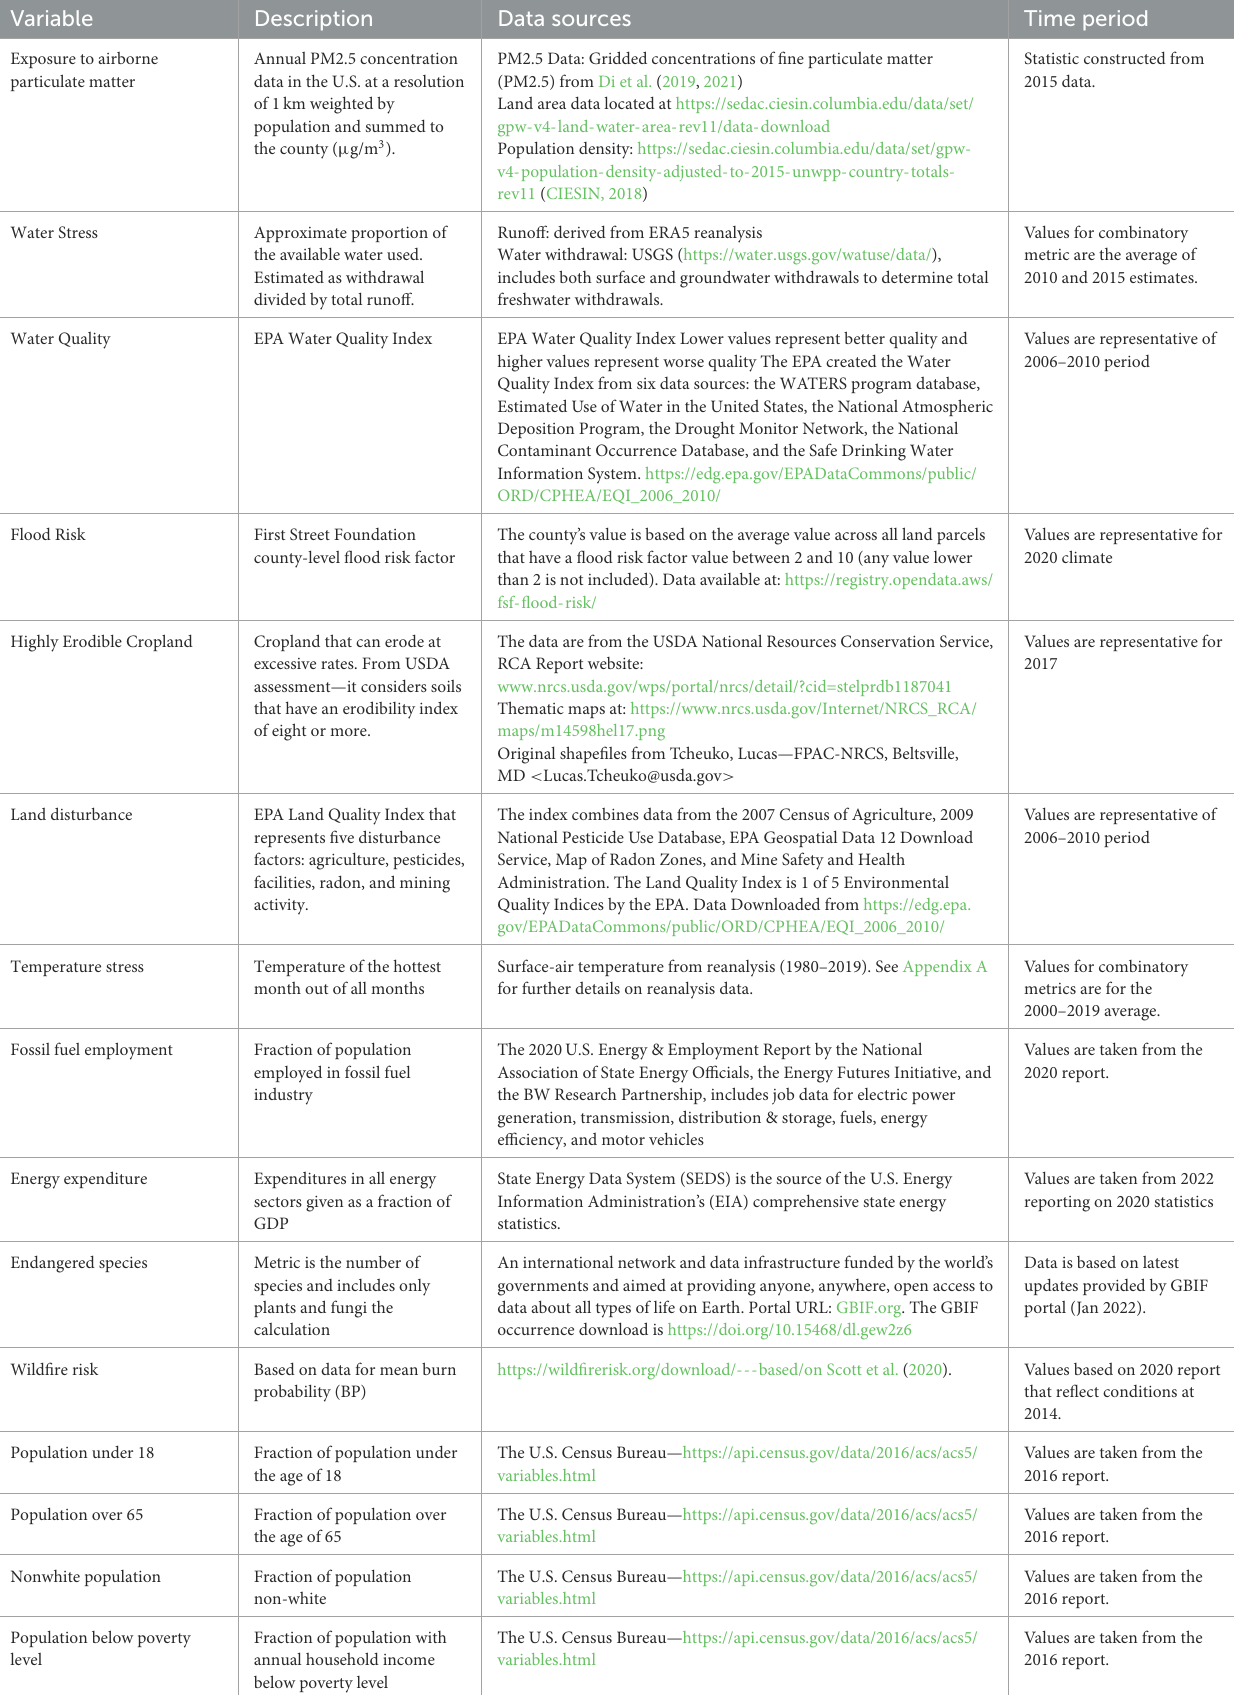
TABLE 1 Description and data-source information for the risk metrics that have been constructed for the combinatory